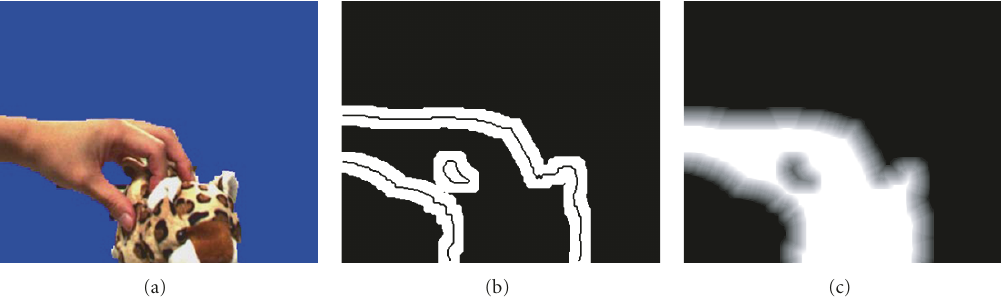
Figure 5: (a) Segmentation result, (b) coherence strip, and (c) spatio-temporal coherence